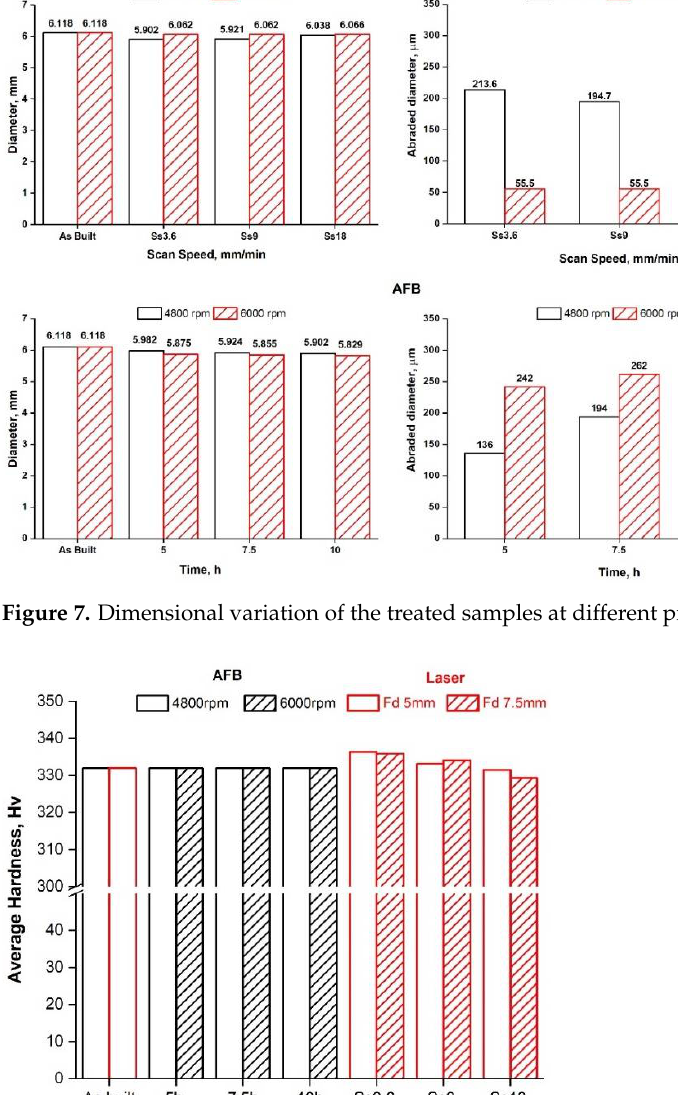
Figure 8. Average hardness at different process conditions.